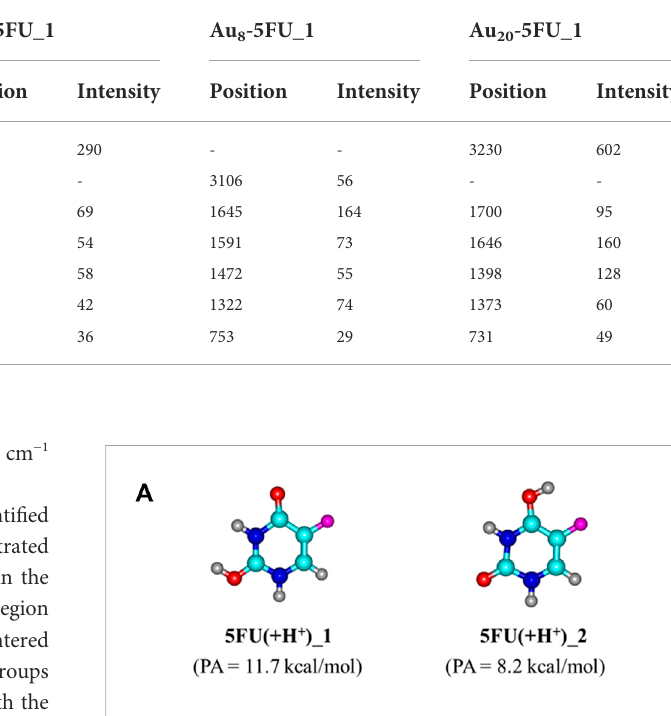
TABLE 3 Selected Raman frequencies (in cm − 1 ) and intensities (in arbitrary unit) for 5FU and its complexes Au 6 -5FU_1 computed in aqueous solution.